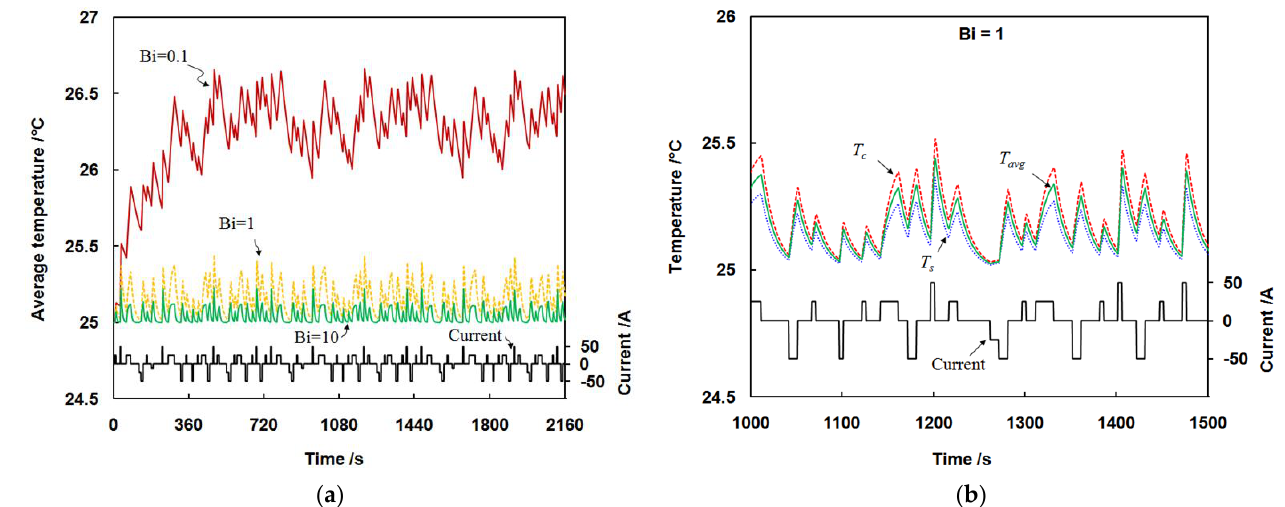
Figure 9. ( a ) The prediction of average cell temperature under three Biot numbers and ( b ) core, surface, and average temperatures for Bi = 1 based on H 0,0 / H 1,1 approximation under a FUDS cycle. Reprinted with permission from [38] . Copyright 2013 Elsevier.